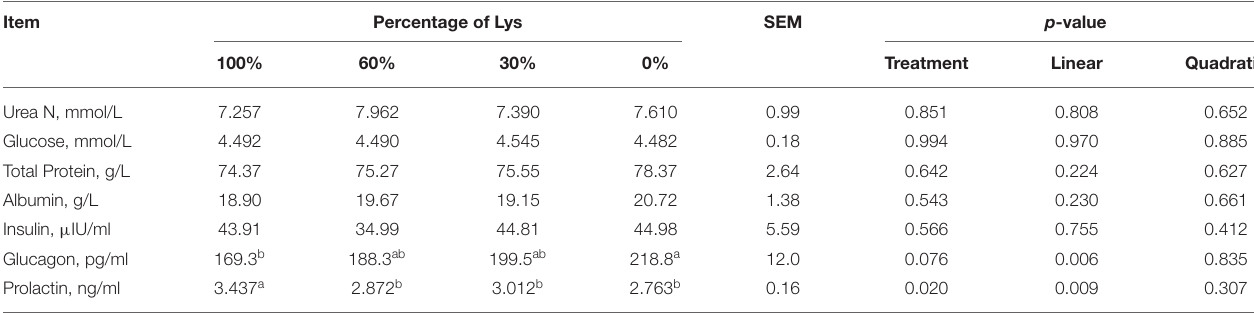
TABLE 5 | Effects of graded removal of Lys from the AA mixture infused into abomasum on concentrations of metabolites and hormones in the plasma of carotid artery in lactating goats.